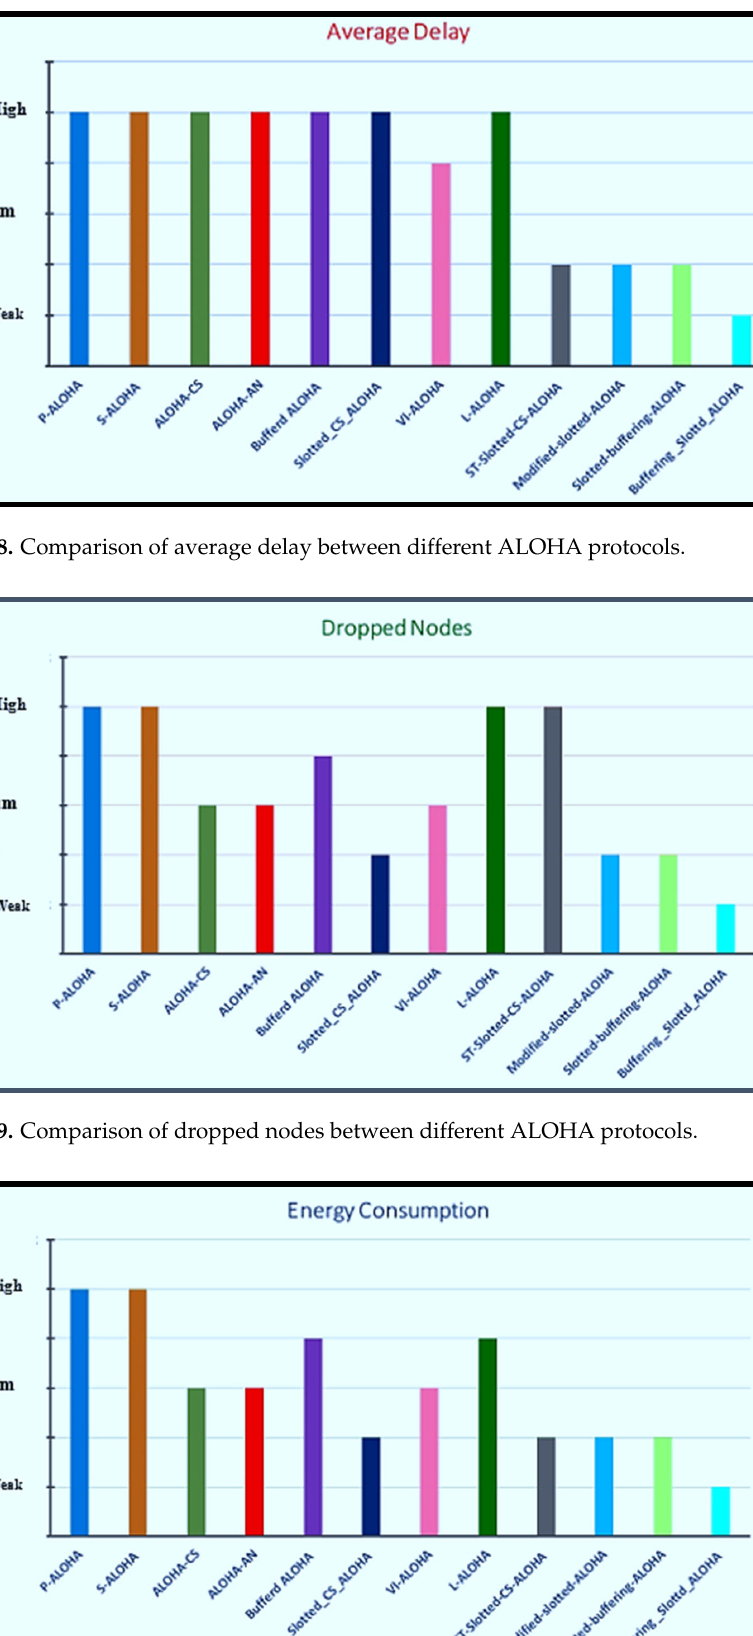
Figure 11. Comparison of throughput between different ALOHA protocols. (xiii) ALOHA by collision avoidance and ALOHA by prior notification (Aloha ‐ CA, Aloha ‐ AN) The authors of the [110] have proposed two different types of ALOHA protocol, i.e., ALOHA by conflict avoidance (ALOHA ‐ CA), and ALOHA by prior notification (ALOHA ‐ AN). These both types are making the communicating system being able to in ‐ crease the efficiency and lower the energy consumption by decreasing the amount of col ‐ lisions between data packets in a UWSNs. To avoiding conflicts in ALOHA ‐ CA, each node monitors the channel’s condition, so that to keep a check on the noisy moment generated by a given frame of the channel’s independent alternatives. This process is upgraded to ALOHA ‐ AN by adding a transmission node, that has the capability to sends an acknowl ‐ edgement to its neighbors prior to data transfer between nodes. The ALOHA ‐ AN is re ‐ source intensive as compared to ALOHA ‐ CA. (xiv) Tone ‐ Lohi (T ‐ Lohi) Another MAC energy ‐ efficient protocol is created on a tone based booking technique [53]. The sender node communicates a small tone as well as hears the channel during a dispute cycle. The transmitter channel is reserved in case if other communicating tones